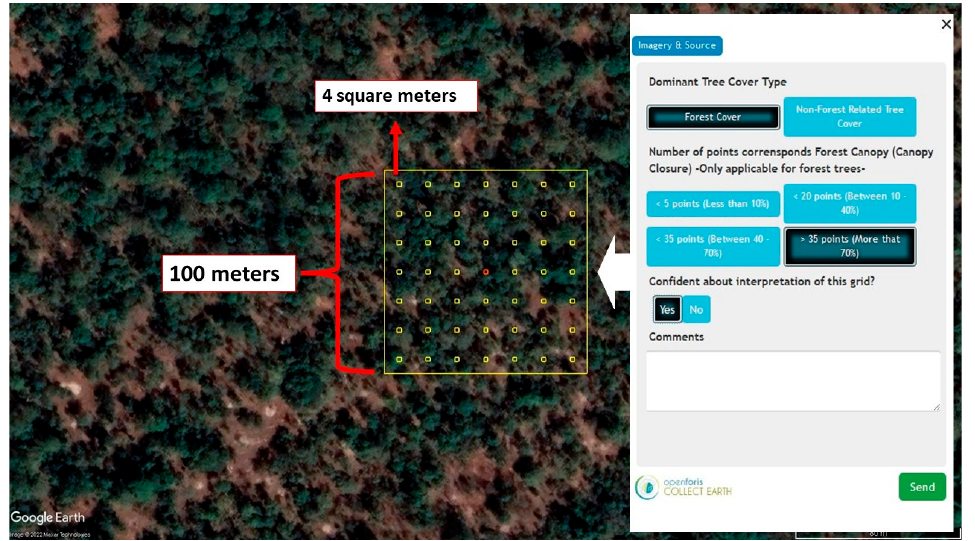
Figure 5. One example of the visual interpretation grids used in this study and the identification card on the right side to collect information about the grid. Table 3. Calculated vegetation indices in this study to classify canopy cover. Coastal Aerosol, Blue, Green, Red, Near-Infrared (NIR), and Shortwave-Infrared 2 (SWIR2) bands of Landsat 8 OLI were used to calculate these indices.